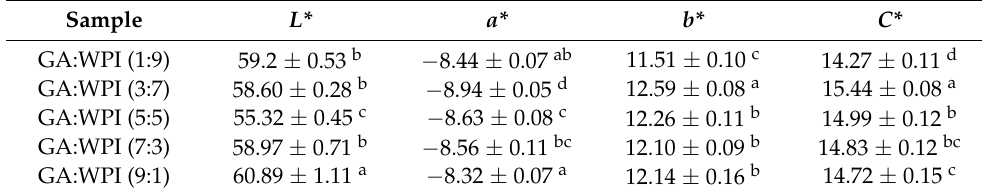
Table 2. The visual color of microcapsules in different ratios of GA and